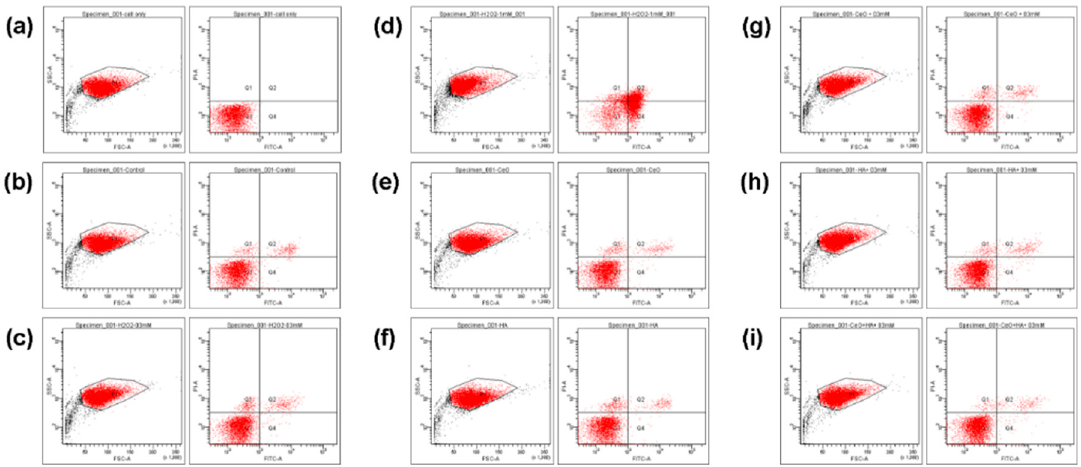
Figure 6. The representative results of cell apoptosis assay by flow cytometry. ( a ) Normal unstained cell for gating; ( b ) Control group; ( c ) 0.3 mM H 2 O 2 ; ( d ) 1 mM H 2 O 2 ; ( e ) CeO 2 biocompatibility assay; ( f ) hyaluronic acid (HA) biocompatibility assay; ( g ) CeO 2 protection; ( h ) HA protection; ( i ) CeO 2 /HA protection. The combination of 0.01 ug / mL CeO 2 nanoparticles / 1% HA could protect chondrocytes from the harmful e ff ect induced by 0.3 mM H 2 O 2 Table 1. The percentage of each quadrant of figures of flow cytometry.